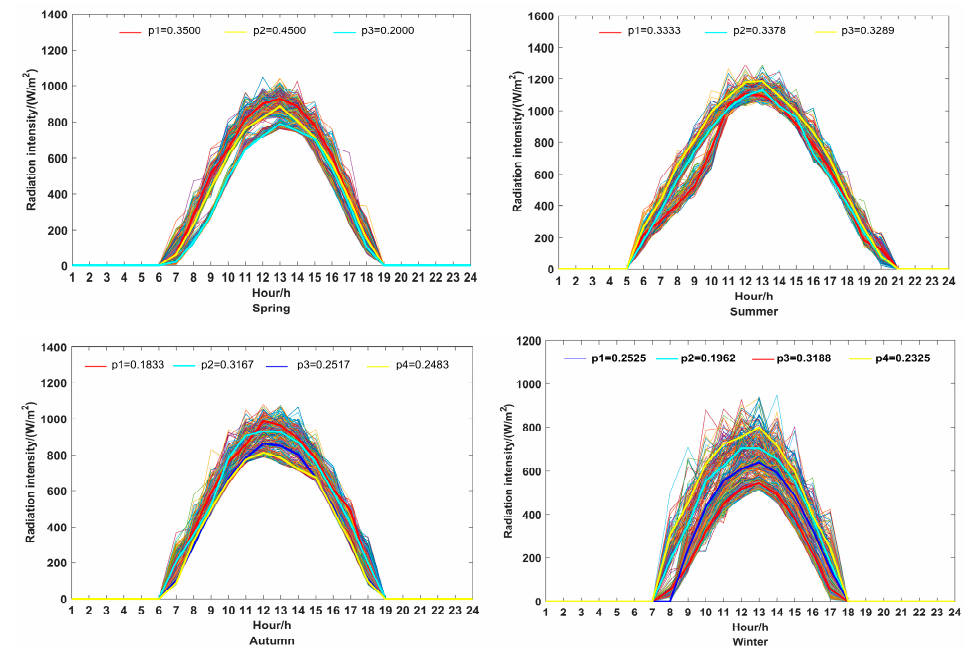
Figure 7. Radiation intensity scenario and probability.